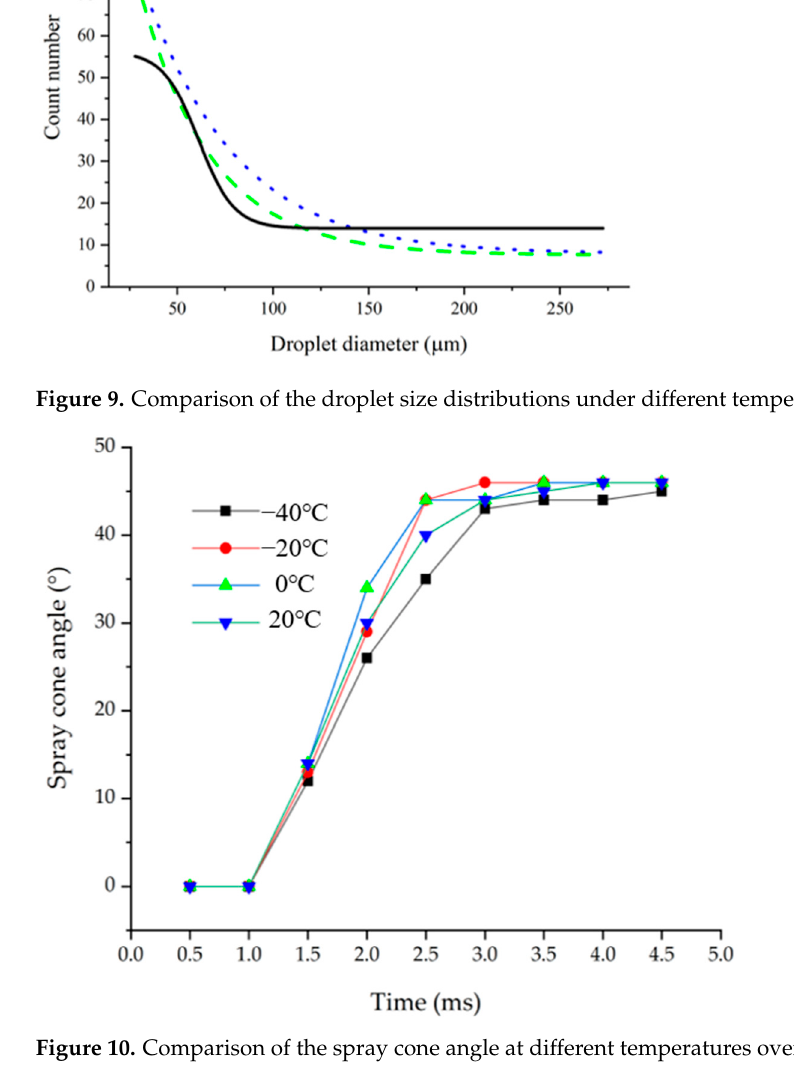
Figure 11. Comparison of the breakup distances at different temperatures over time. 4. Conclusions The spray of MMH at low temperatures was investigated numerically based on the VOF method and the LES model, employing the open code OpenFOAM with the ARM method. A parametric comparison was conducted to investigate the spray development at different temperatures, including the velocity distribution, liquid total surface area, droplet size distribution, spray cone angle and breakup distance. The following conclu- sions are drawn: (1) The swirl spray of the MMH injector is distributed in the stable shape of a hollow cone spray, with a slight sensitivity to different temperatures. As the temperature decreases from 20 °C to − 40 °C, the penetration distance and ejection velocity of the